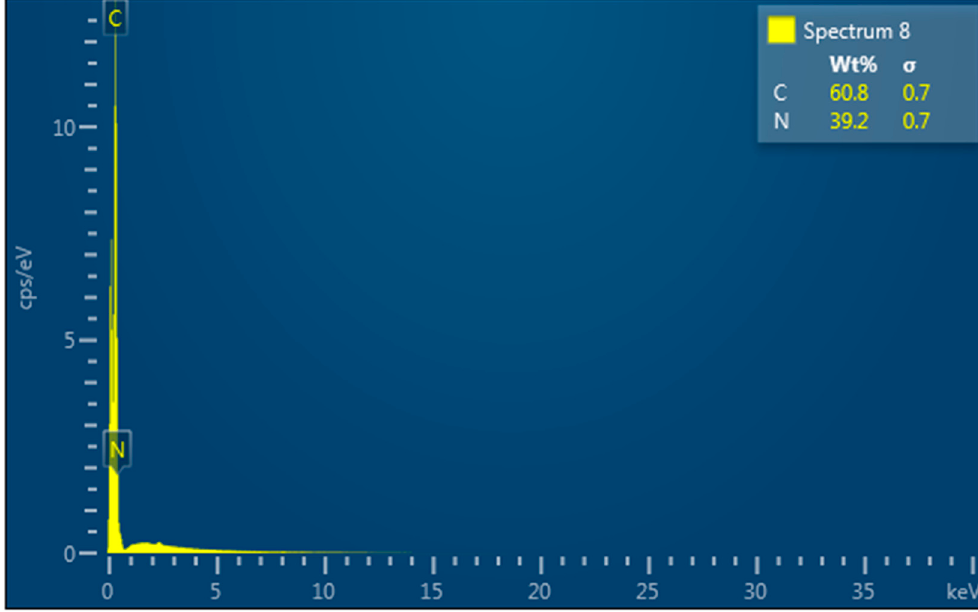
Figure 2. EDS spectrum showing the elemental composition of the crushed raw PAN.